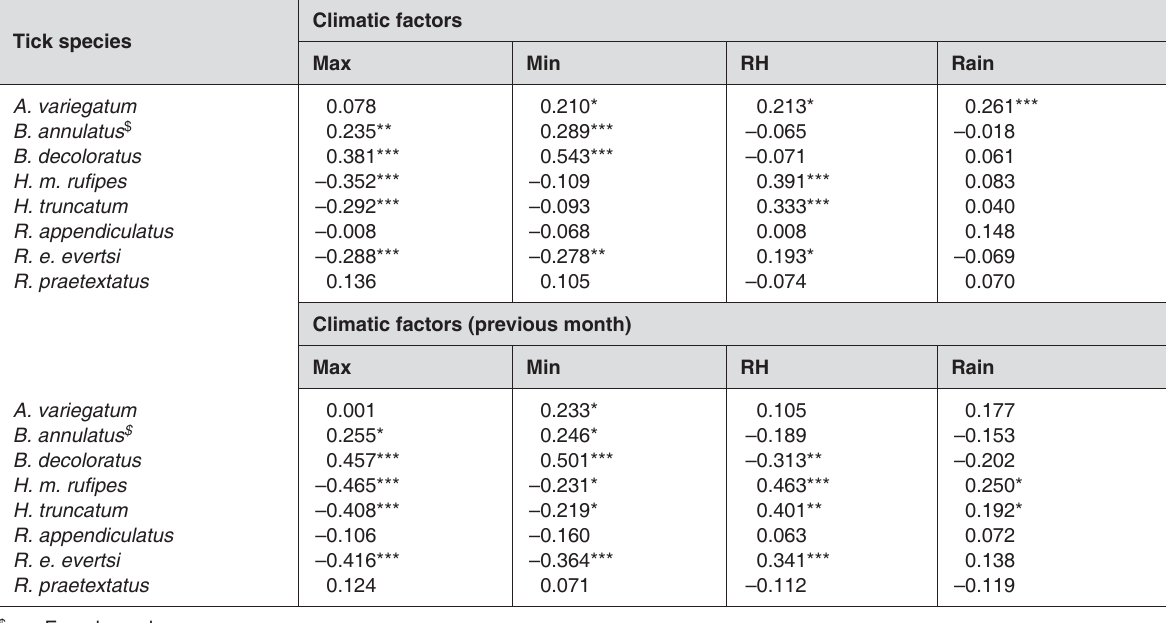
TABLE 4 Correlation analysis between means of total body tick collection and climatic factors in Central Equatoria State, Southern Sudan during the year 2005